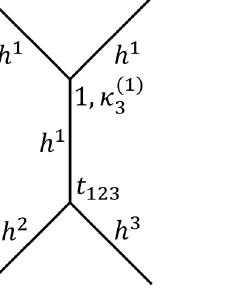
Figure 14 . Leading Feynman diagrams for inelastic scattering h 1 h 2 → h 1 h 3 in a multi-field Λ 3 cycle